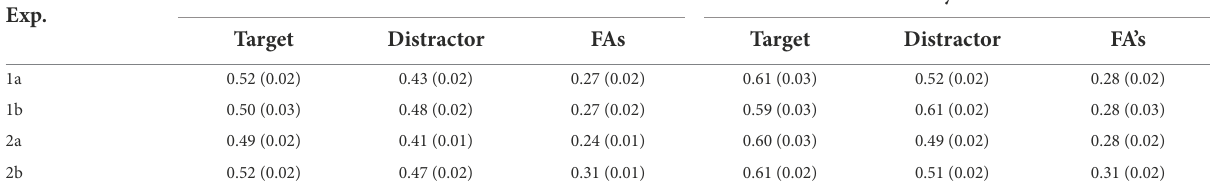
TABLE 1 Proportions of hits and false alarms for each condition in Experiments 1a, 1b, 2a, and 2b. Standard errors corrected by removing overall between-participant variance are presented in parentheses (Morey, 2008).